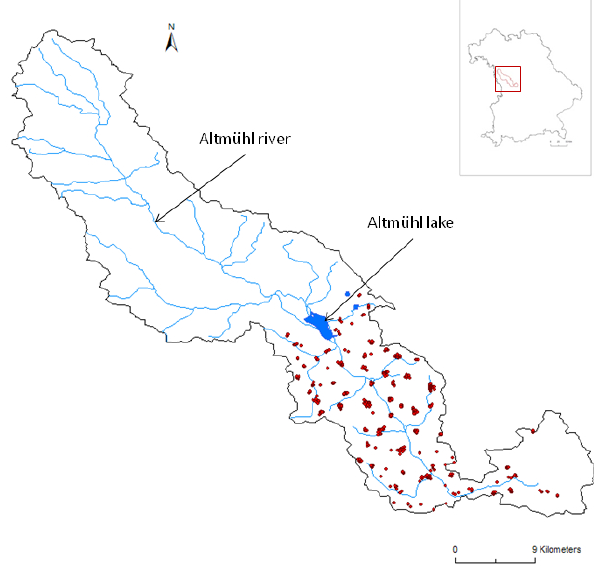
Fig. 1. Location of farms in the study area (upper Altm¨uhl water- shed) where a questionnaire was sent (each dot represents a farm ad- dress). Inset shows location of the watershed in the State of Bavaria, Germany. (Map source information: Bayerisches Vermessungsver- waltung, 2010).